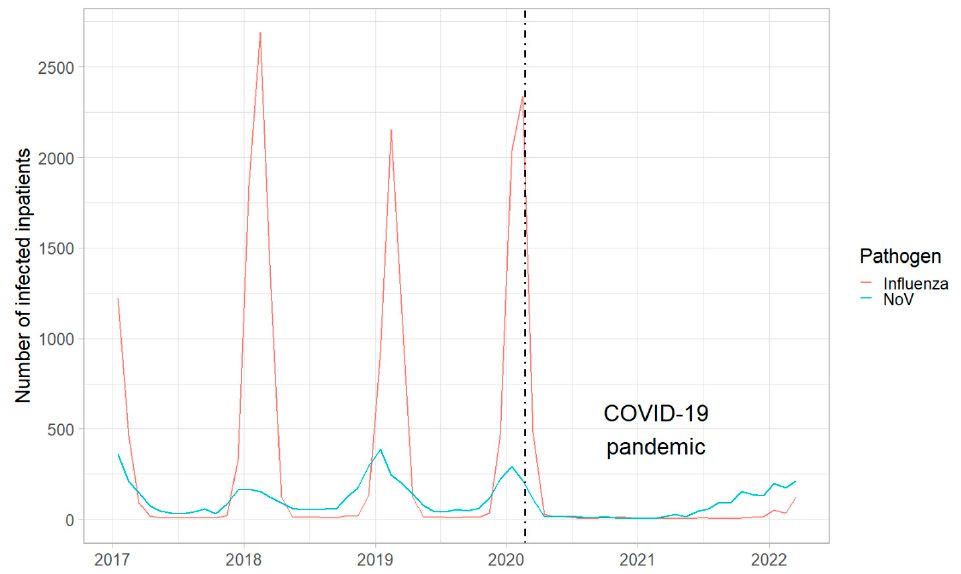
Figure 3. Seasonal occurrence of (red line) influenza virus and (blue line) norovirus infections in inpatients aggregated per month across Austria. The dashed black line marks the date of the first clinical COVID-19 case in Austria.